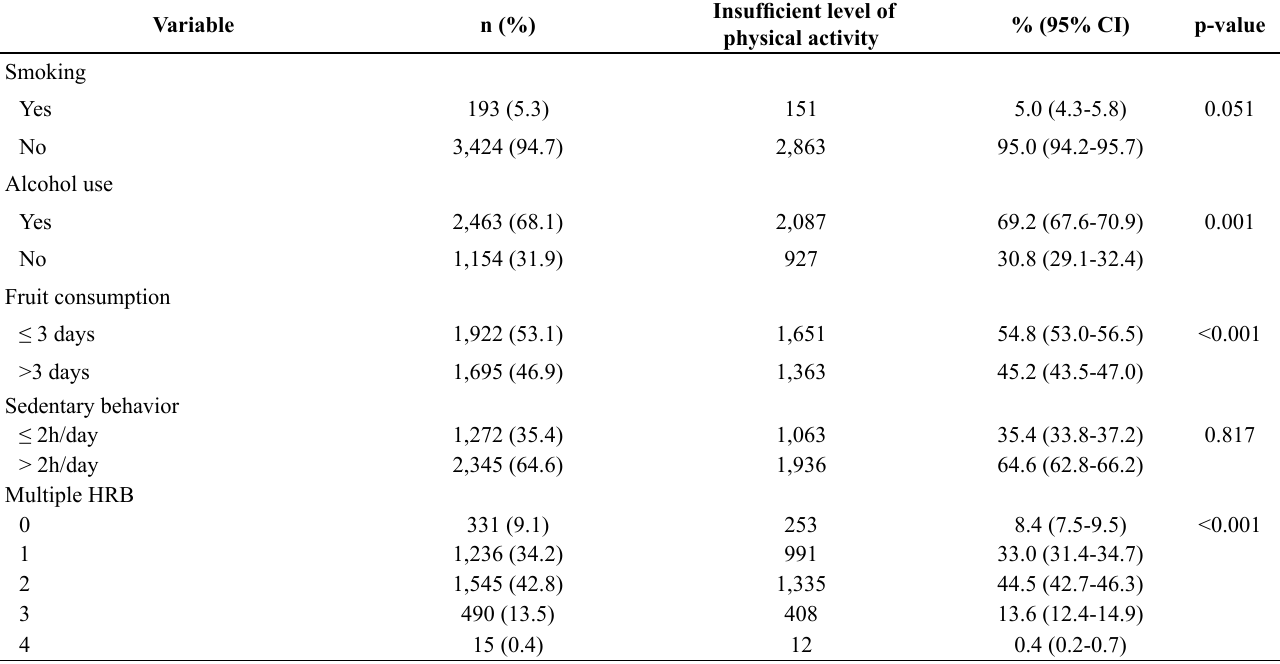
Table 2. Distribution of health risk behaviors among adolescents ( n =3,617), Sergipe, Brazil, 2016. Variable